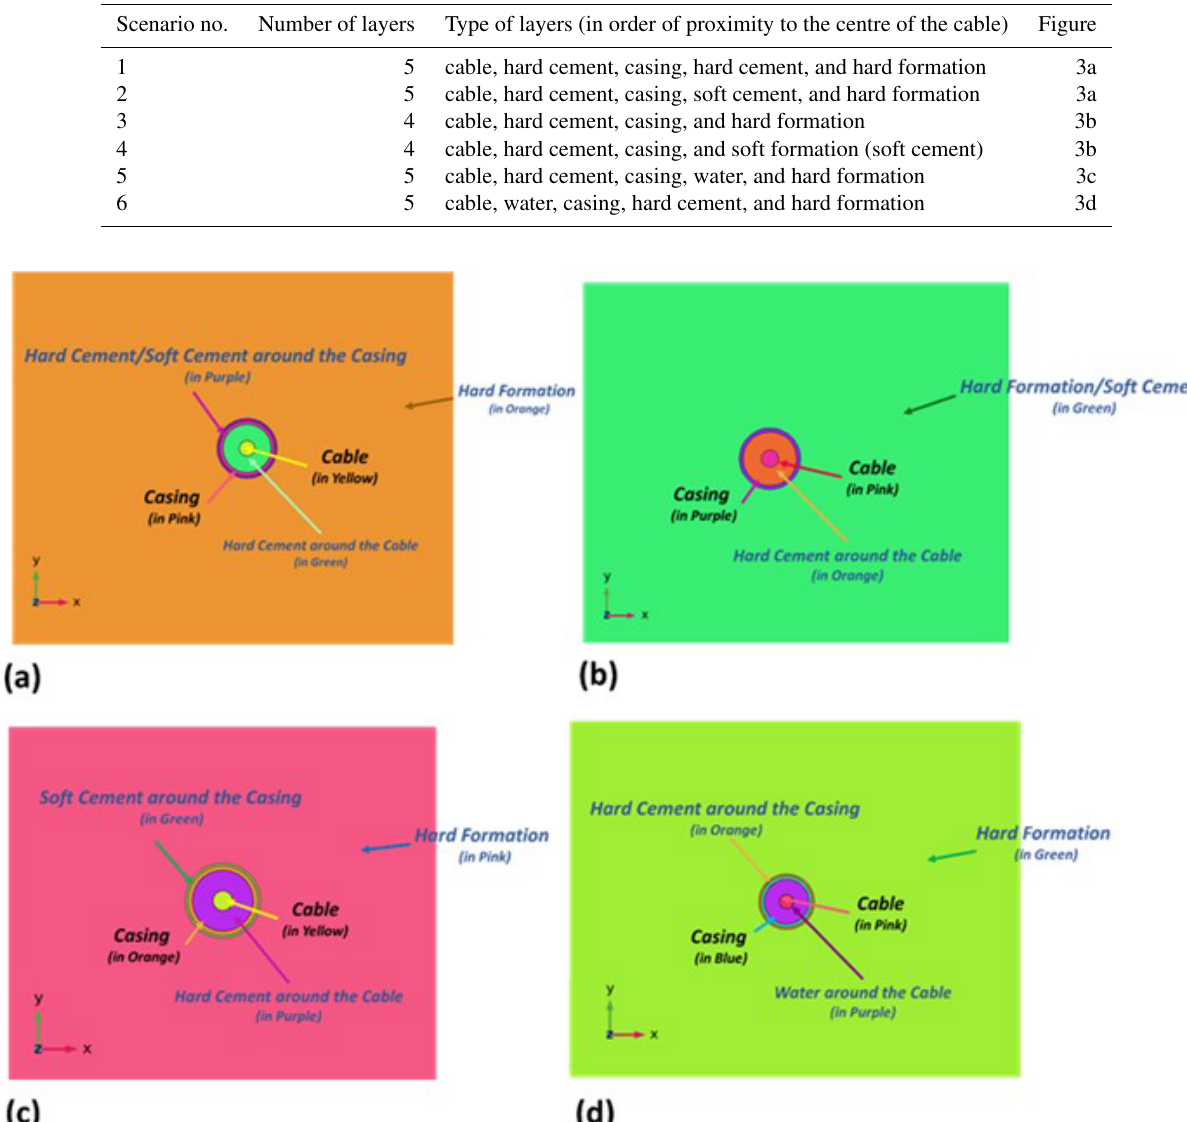
Table 1. Number and type of layers (domain) implemented in numerical modelling for six scenarios. The layers are concentric, as illustrated in Fig. 3.